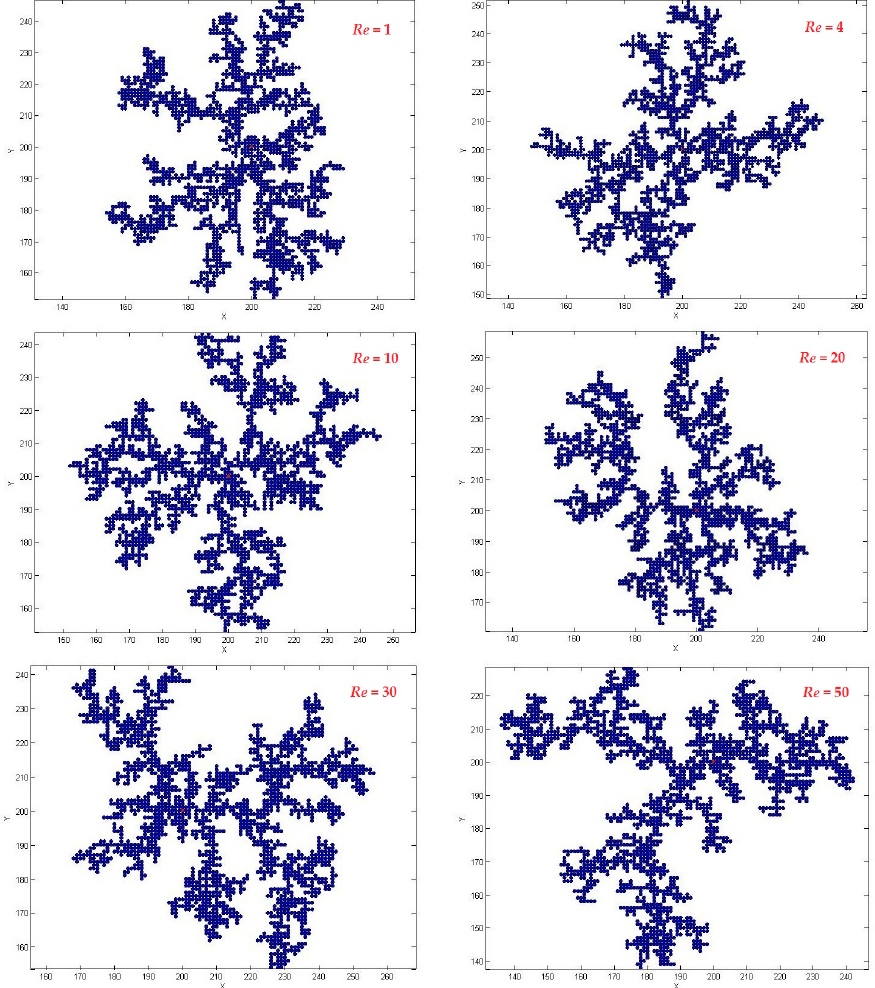
Figure 8. 2D DLA aggregates with various launch radii.